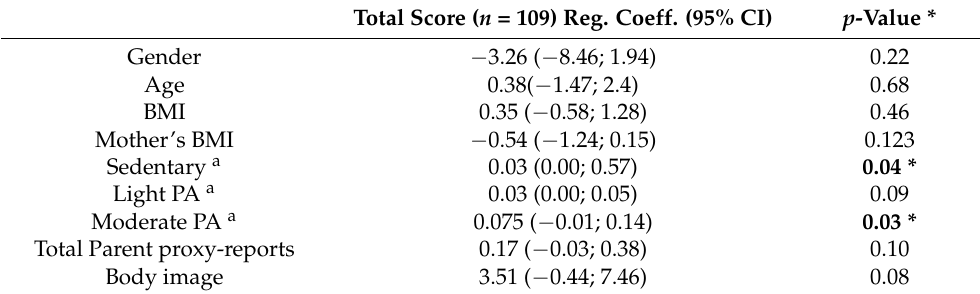
Table 2. The associated factors of health-related quality of life in children for the total score domain. Total Score ( n = 109) Reg. Coeff. (95% CI)